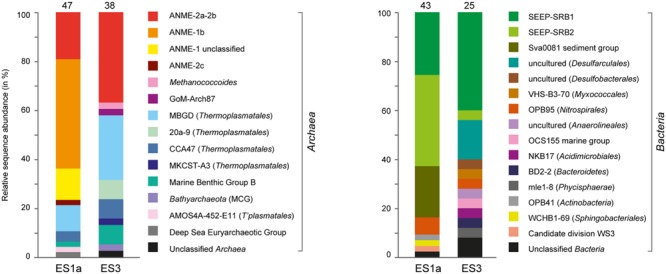
Relative sequence abundances of archaeal and bacterial 16S rRNA genes at emission spot 1a (ES1a) and 3 (ES3). The number of analyzed clones is given above the columns. The nomenclature of uncultivated groups is according to SILVA taxonomy.